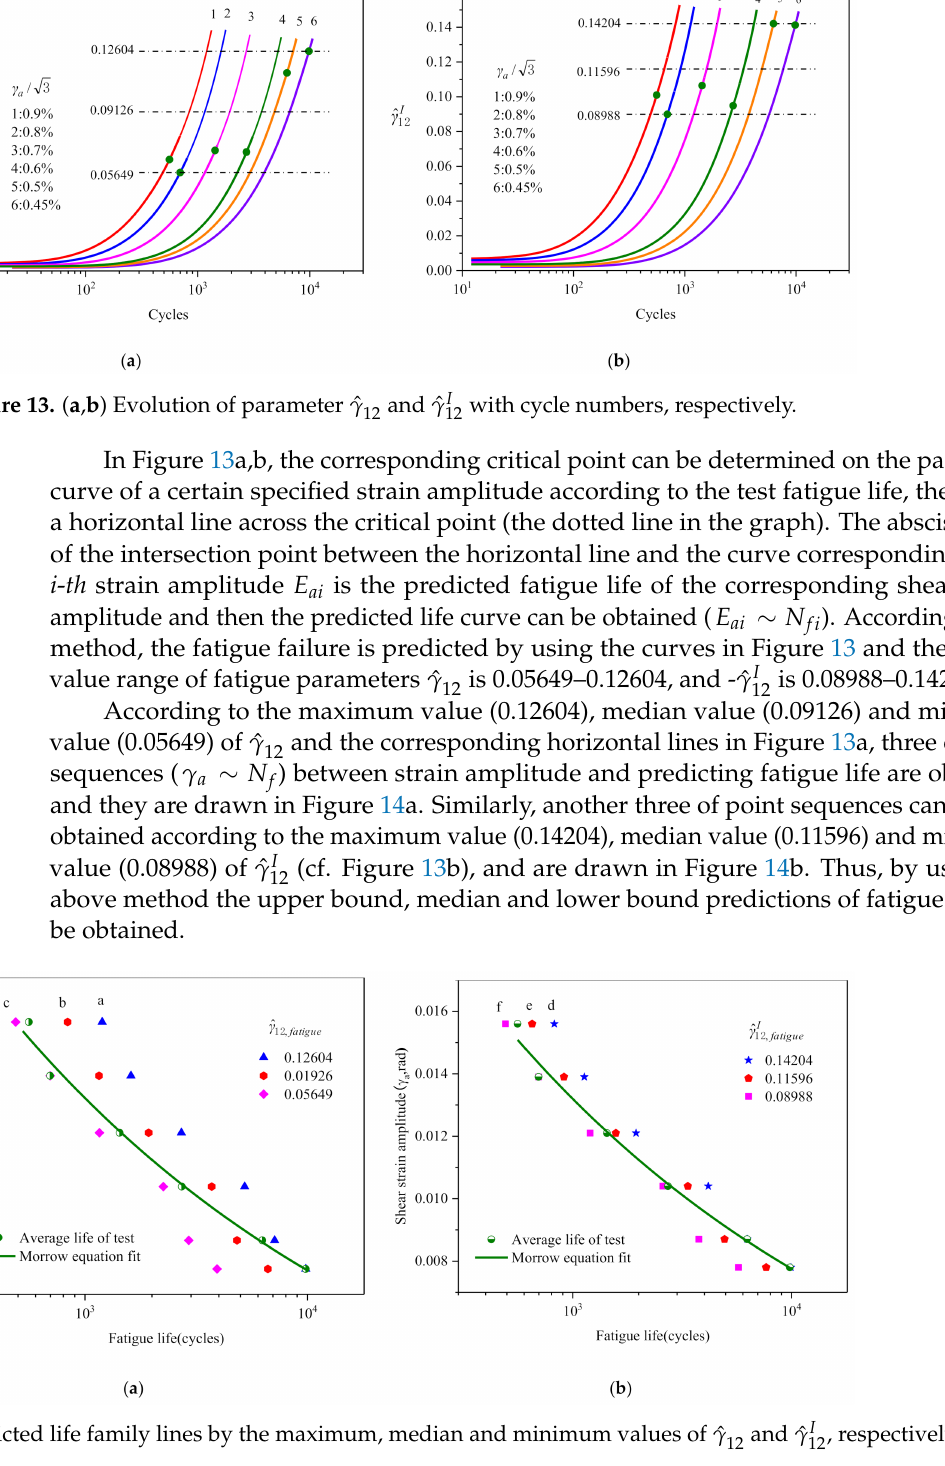
and ˆ γ I , 12 12